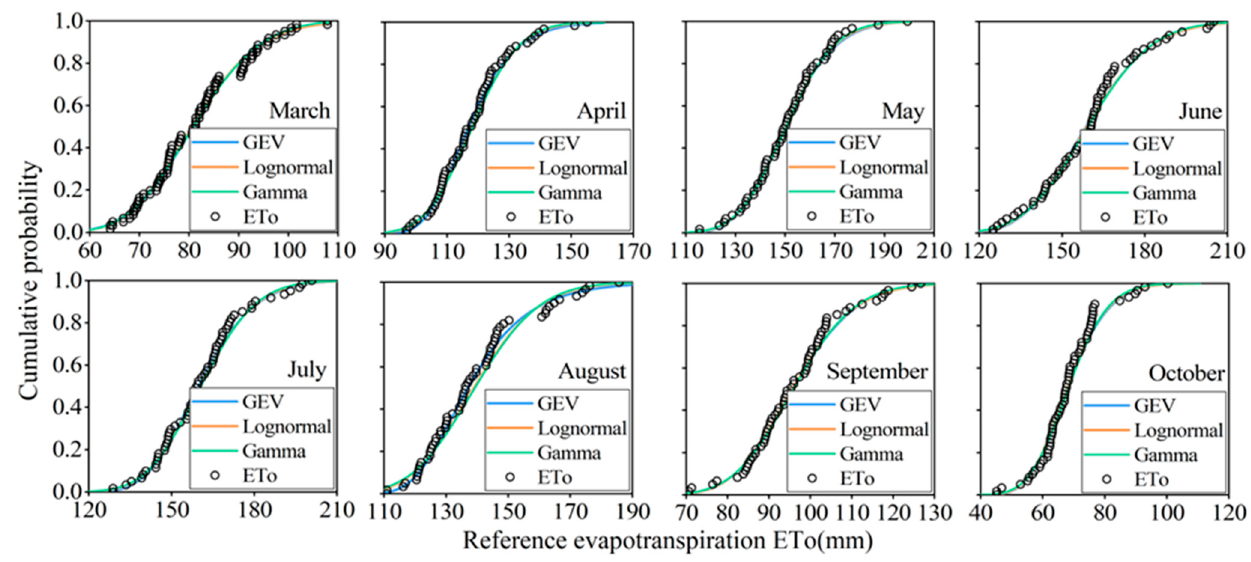
Figure 8. Fitting diagram of marginal distribution for monthly reference evapotranspiration. (The points represent monthly reference evapotranspiration calculated by weather data from 1960 to 2020. The curves represent the fitting results of three marginal distribution functions). Table 4. Parameters of marginal distribution for monthly reference evapotranspiration.